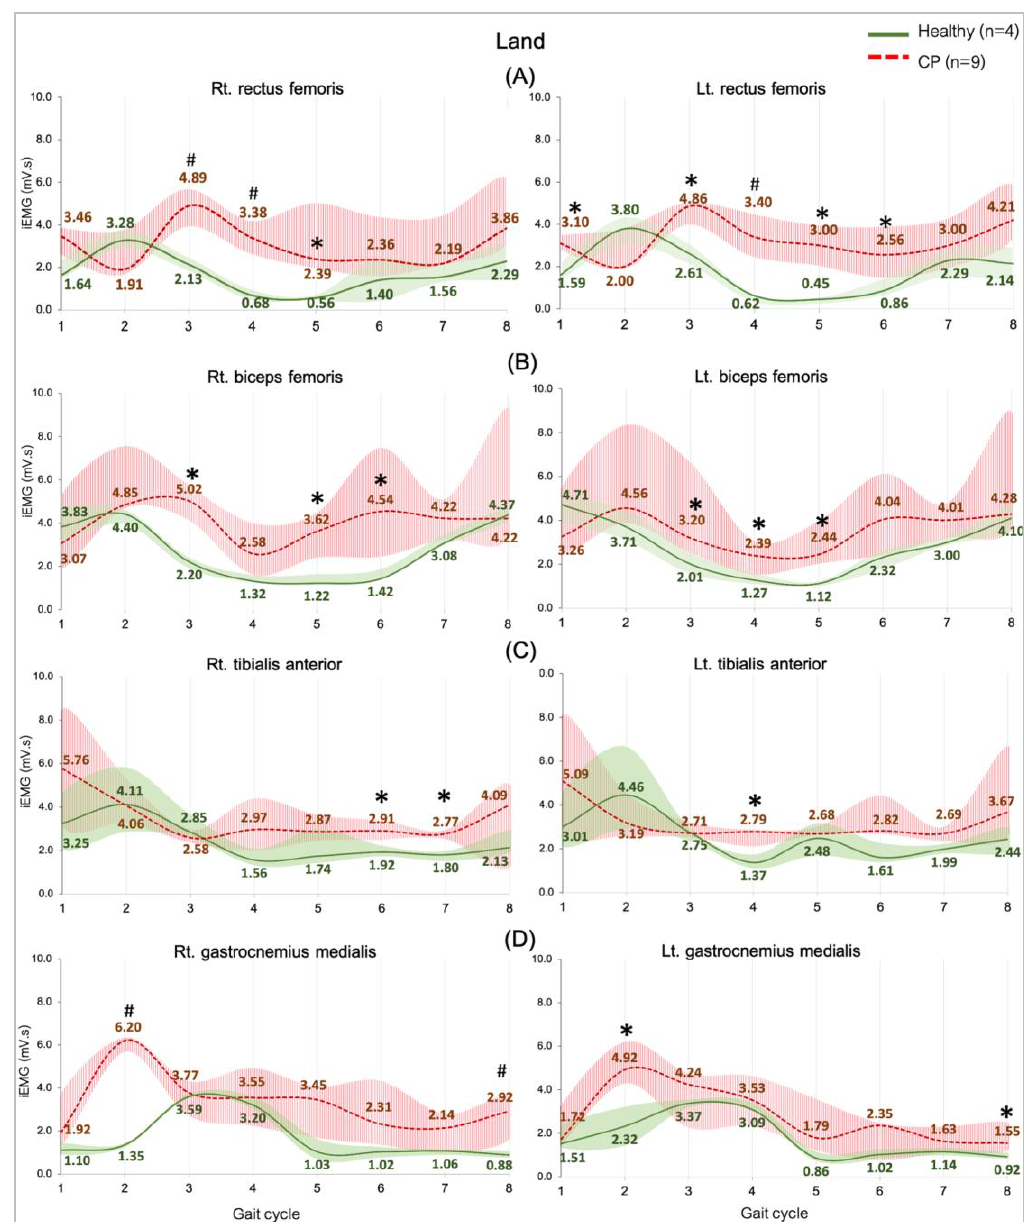
Figure 4. EMG activity during walking on land in the healthy (n = 4) and CP individuals (n = 9). Rectus femoris, RF ( A ), biceps femoris, BF ( B ), tibialis anterior, TA ( C ), and gastrocnemius medialis, GM ( D ). Gait phases: 1 = initial contact, 2 = loading response, 3 = mid stance, 4 = terminal stance, 5 = pre swing, 6 = initial swing, 7 = mid swing, and 8 = terminal swing. * and # are significant median differences between walking on land and in water at p < 0.05 and p <